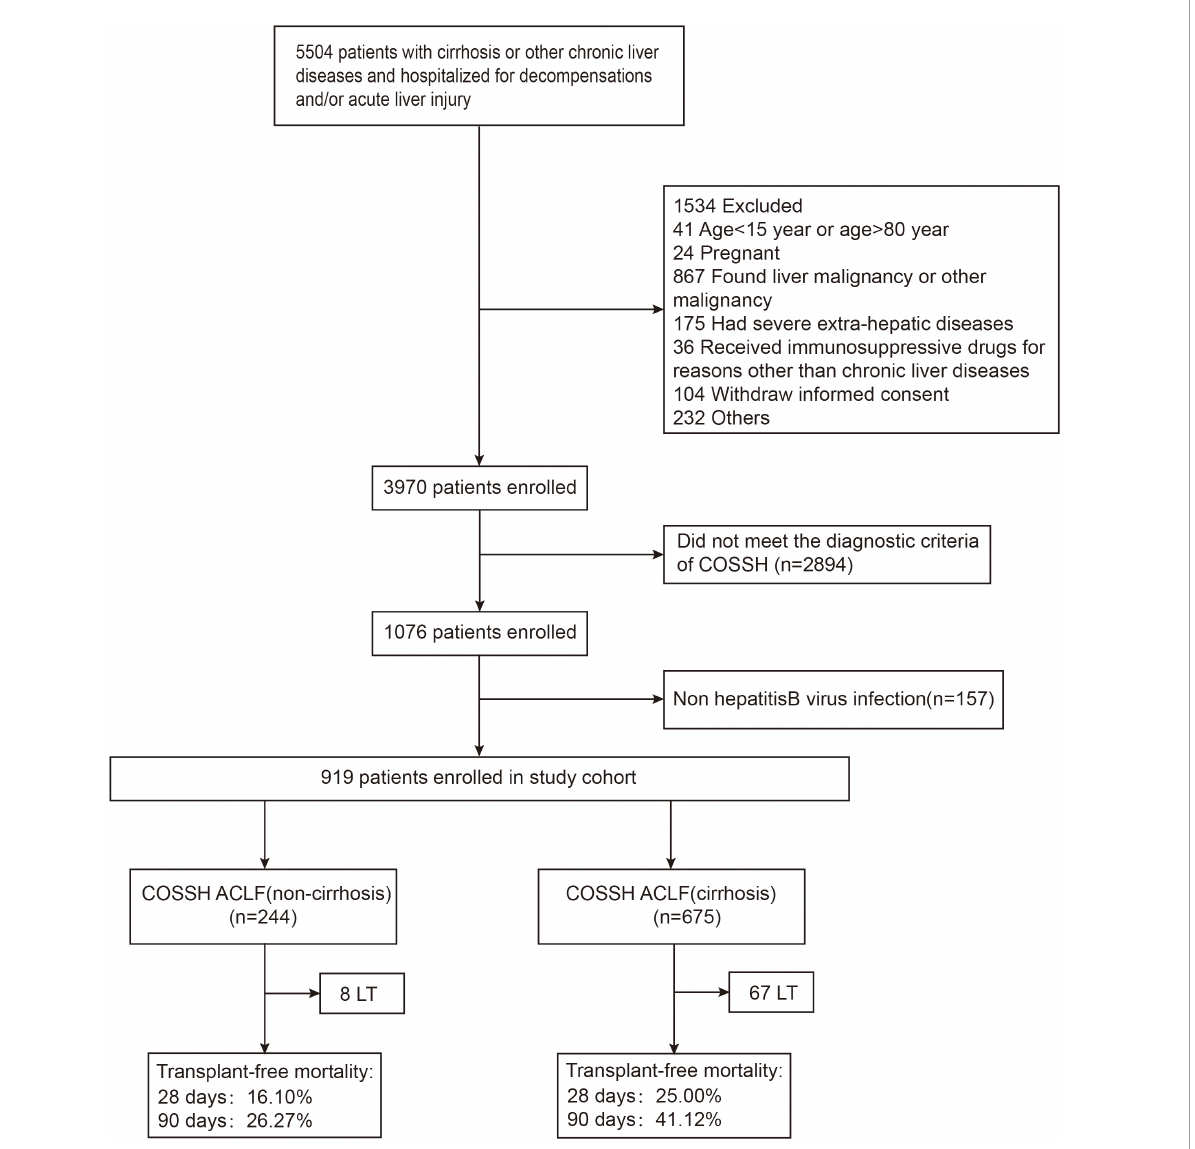
FIGURE1 The flowchart of study selection. LT, liver transplantation; COSSH, Chinese Group on the Study of Severe Hepatitis